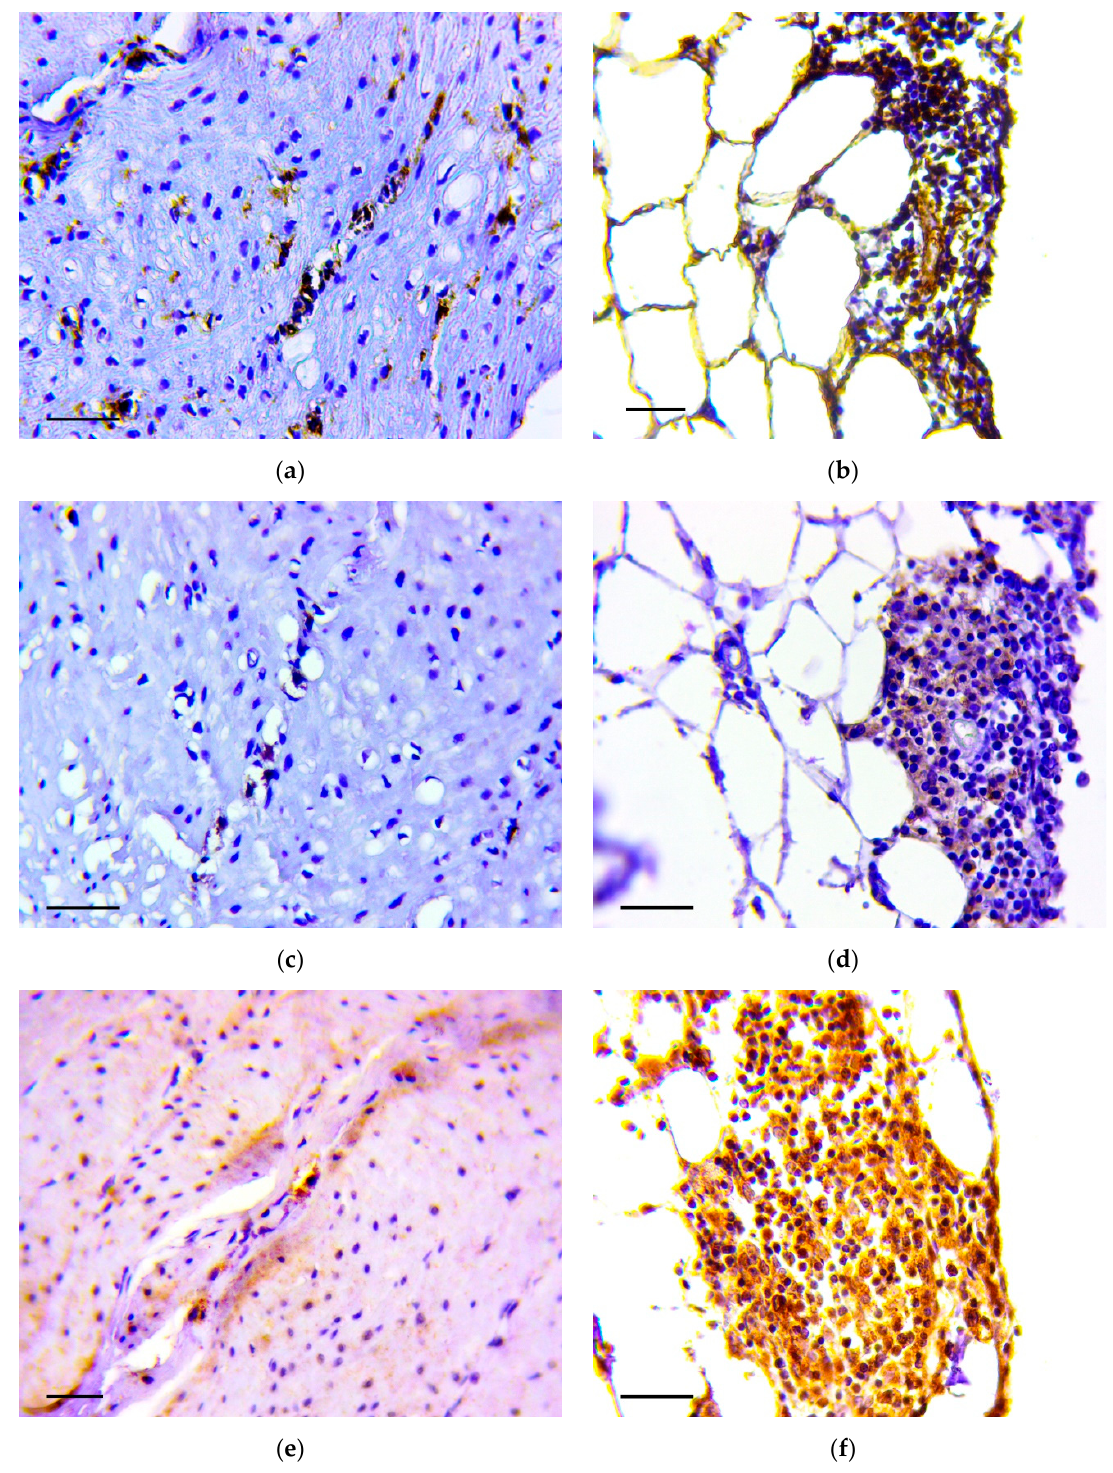
Figure 5. Invasion of tumor cells in the muscle layer ( a , c ,d) and in omentum ( b , d , f ). Positive reaction to vimentin ( a , b ), Snail ( c , d ) and TGF- β 2 ( e , f ). Immunoperoxidase staining with antibody to vimentin, Snail and TGF- β 2, scale bar 100 µm.